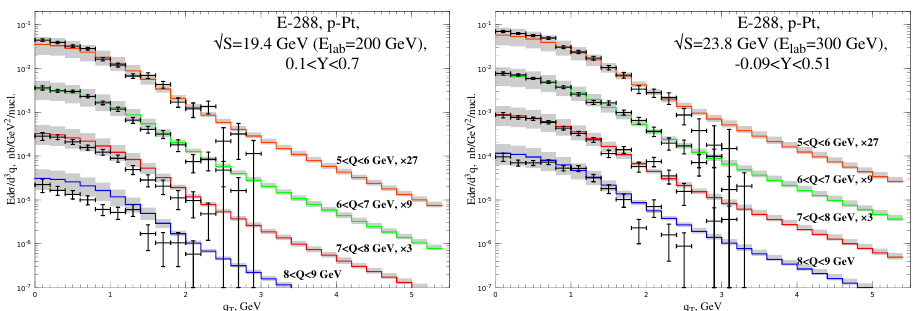
Figure 2. Transverse momentum spectra of DY pairs. The histogram corresponds to calculation in PRA. The data are from the E288 Collaboration [14], left panel: √ S = 23 . 8 GeV, − 0 . 09 < Y < 0 . 51 panel: